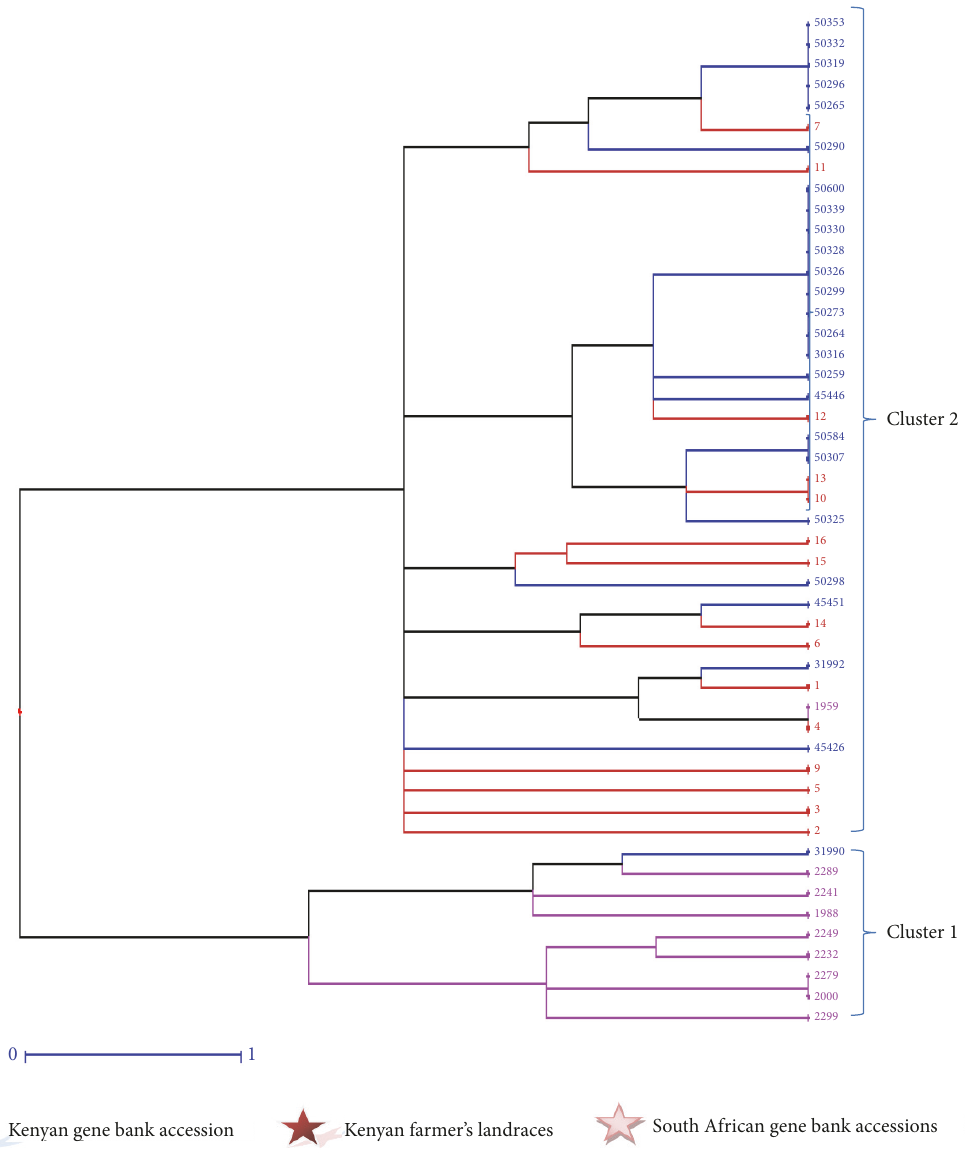
Figure 1: Phenogram showing relationship among accessions characterized using morphological traits.